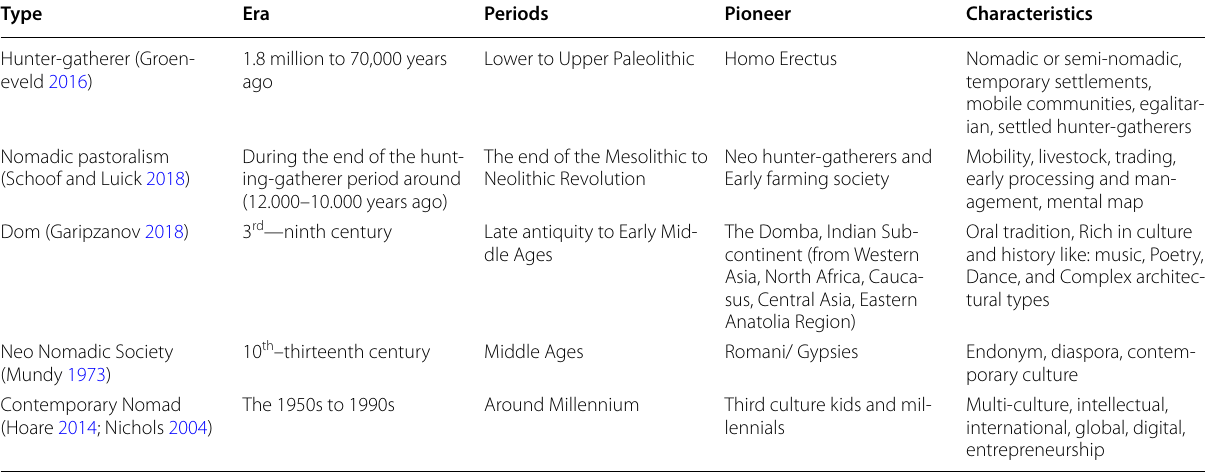
Table 2 Nomadic culture evolution